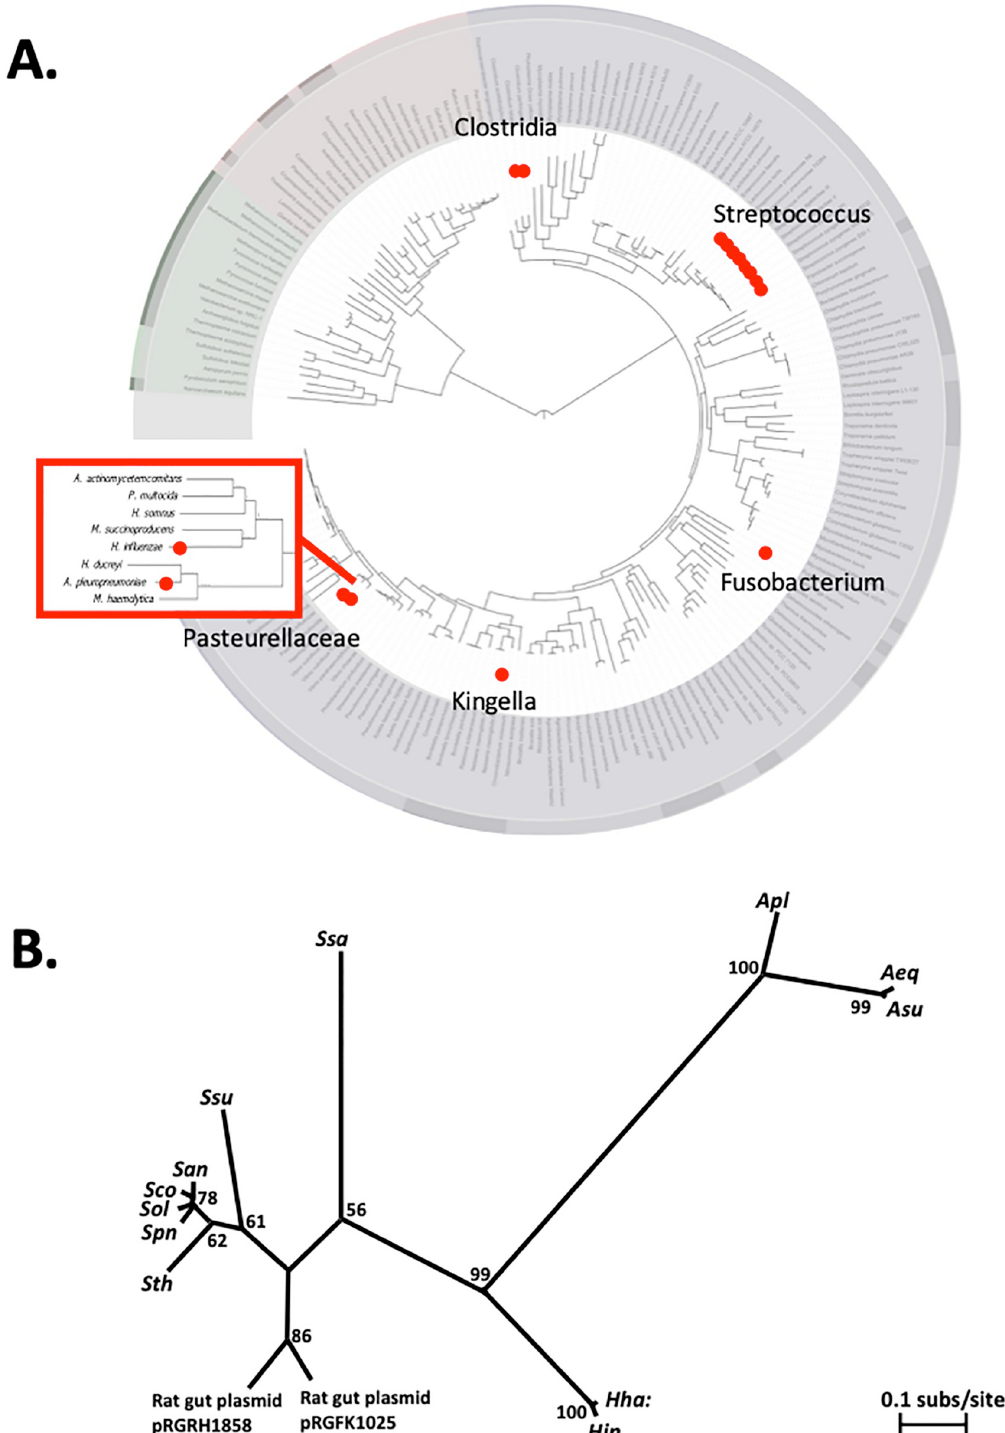
Fig 3. Distribution of toxTA homologs in bacterial genomes. A . Summary of tBLASTn results. Red dots indicate one or more taxa containing homologs of both ToxT and ToxA. Bacterial phylogeny image from Wikimedia Commons [16]. Inset: Pasteurellacean phylogeny from Redfield et al . 2006. B . Unrooted maximum likelihood phylogeny of concatenated ToxT and ToxA homologs from selected species where both were detected. Numbers at nodes are bootstrap values. Species abbreviations: Apl : Actinobacillus pleuropneumoniae; Aeq : A . equuli; Asu : A . suis; Haemophilus haemolyticus; Hin : H .